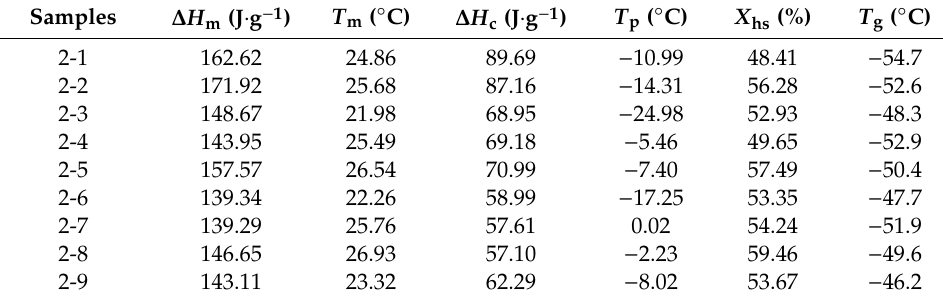
Table 10. Thermal transitions and relative crystallinity of polyether-based TPUs.